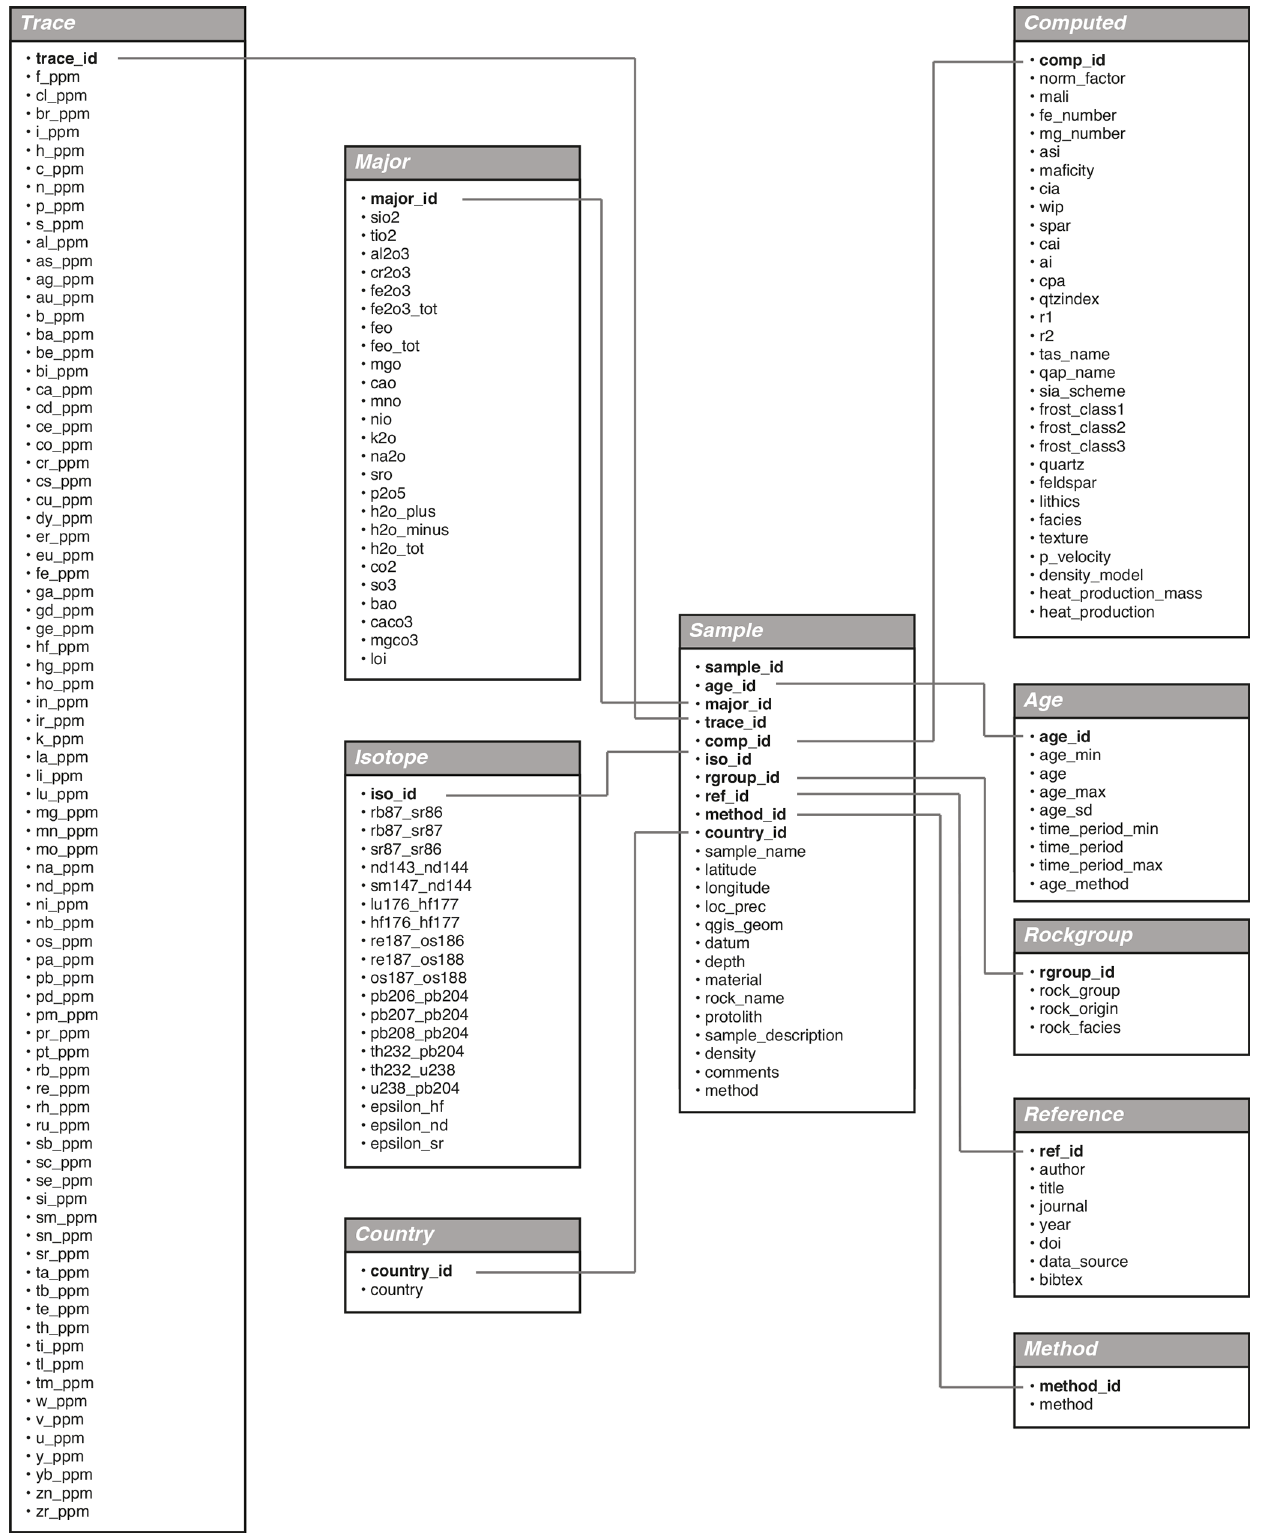
Figure 1. Database relational structure. Sub-tables are linked through foreign id keys. Ambiguous field names are described in detail in the